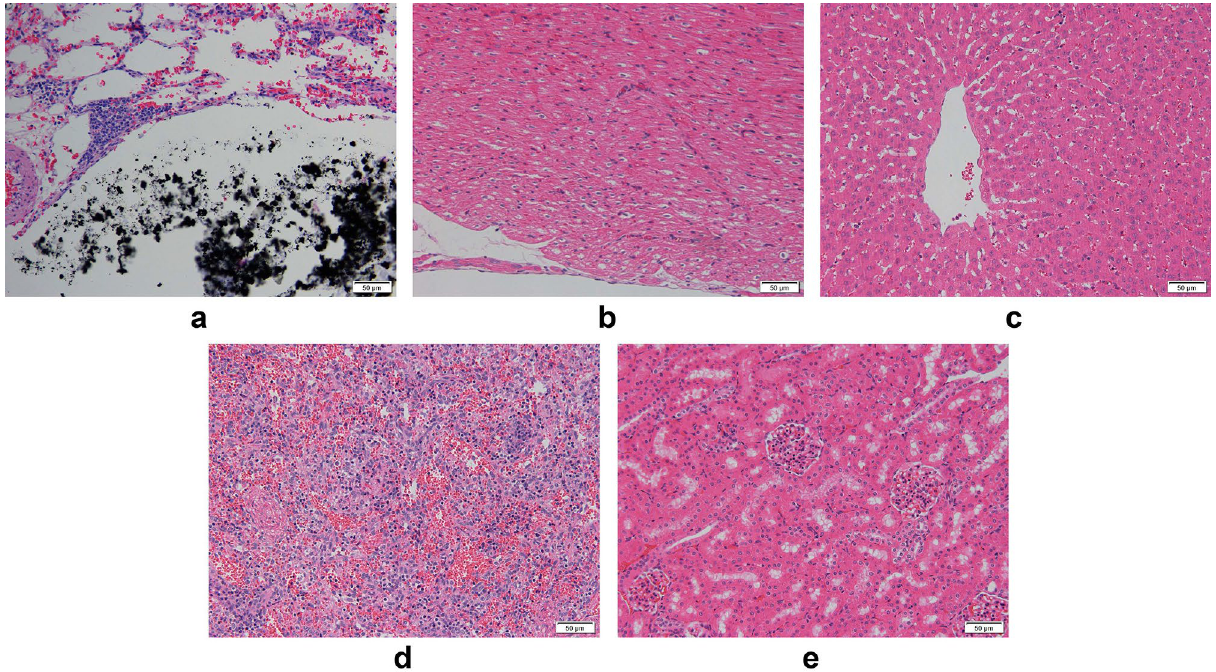
Figure 8. ( a ) Magnetic gel in lung tissue 15 min after injection, ( b – e ) Morphology of ( b ) heart, ( c ) liver, ( d ) spleen, and ( e ) kidney tissues 15 min after injection (hematoxylin–eosin staining, 200